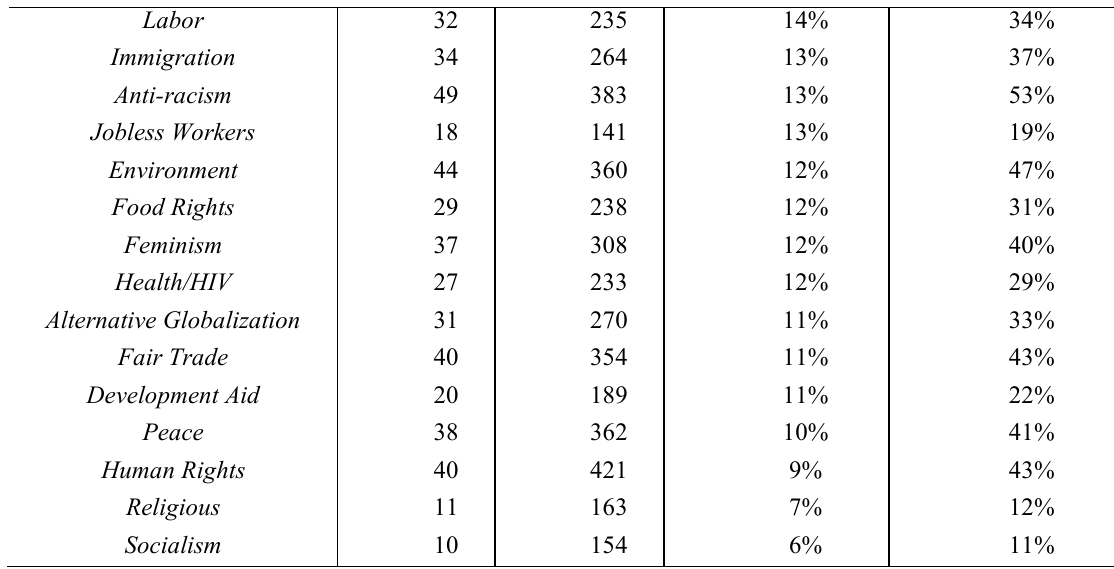
Figure 1: Anarchist Ego Network, 3 Survey Dataset (27 movements—No Porto Alegre) Cutting point